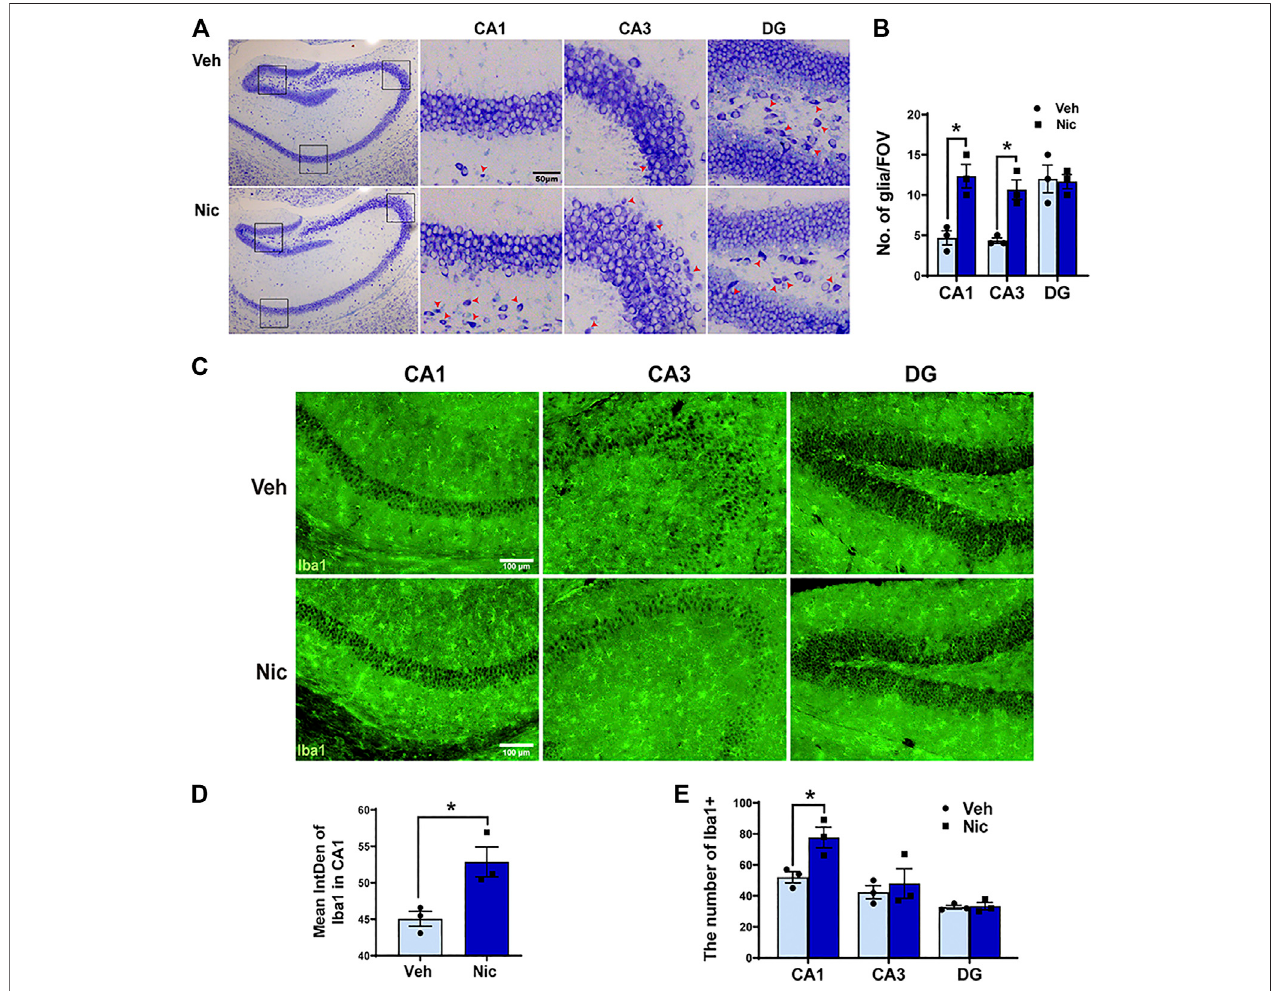
FIGURE 2 | Maternal nicotine exposure increased the number of neuroglia microglia, but not pyramidal neurons in the hippocampus of pups. (A) Photomicrographshowedthewholehippocampalsampleinthecoronalplane(twopicturesontheleft-mostside).DG,CA1,andCA3sub fi eldareindicatedbytheblack frameintheleft-mostimage. Maternalnicotine exposure increasedneuroglia(arrowhead)inDG, CA1,andCA3. (B) Neuroglialcellswerequanti fi edinthehippocampus. (C) Iba1-positive cells inthe offspring ’ hippocampiwereanalyzed byimmuno fl uorescence stainingusing fl oated section. The hippocampusof20 day old offspring from the maternal nicotine-exposed group has more microglia cells (green) than the vehicle control. Representative images were shown. The quanti fi cation of immuno fl uorescence staining by ImageJ showed that the expression (D) and number (E) of Iba1 + cells increased obviously in the nicotine group. Scale bar: 50 μ m (A); 100 μ m (B); * p < 0.05, all data are means ±